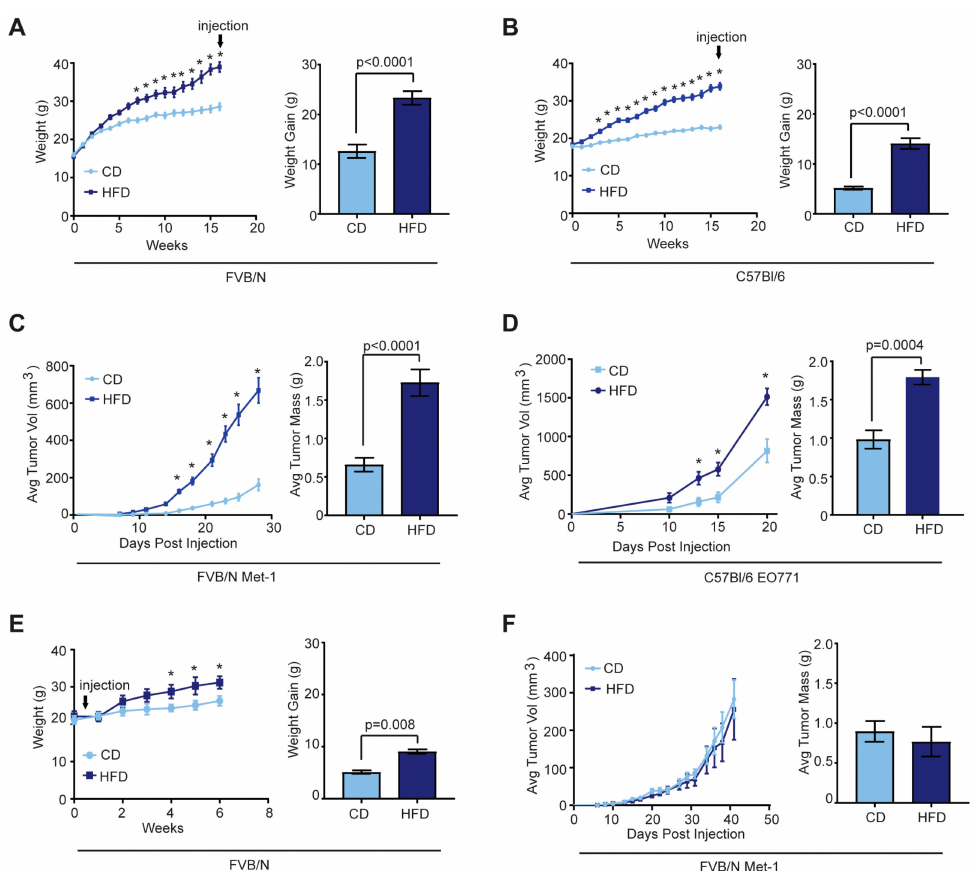
Figure 1. Obesity promotes tumor growth. Average body mass and weight gain of FVB / N ( A , n = 12 / group) or C57Bl / 6 ( B , n = 10 / group) female mice fed a control diet (CD) or high fat diet (HFD) for 16 weeks prior to tumor cell transplant. Average body mass was analyzed using two-way ANOVA and Tukey’s multiple comparison test (* < 0.05); di ff erences in weight gain were assessed with a t -test. Tumor growth curves and end stage tumor mass of Met-1 ( C ) or EO771 ( D ) tumor cells that were transplanted into the inguinal mammary glands of lean or obese FVB / N or C57Bl / 6 female mice, respectively. Tumor growth was analyzed using two-way ANOVA and Tukey’s multiple comparison test (* < 0.05); di ff erences in tumor weight assessed with t -test. ( E ) Average body mass and weight gain of female FVB / N mice placed on the CD or HFD at the time of Met-1 tumor cell transplant ( n = 5 / group). ( F ) Tumor growth curve and end stage tumor mass of Met-1 tumors that were transplanted into the mammary glands of FVB / N mice fed HFD or CD at the time of diet initiation. Tumor growth is represented as mean ±